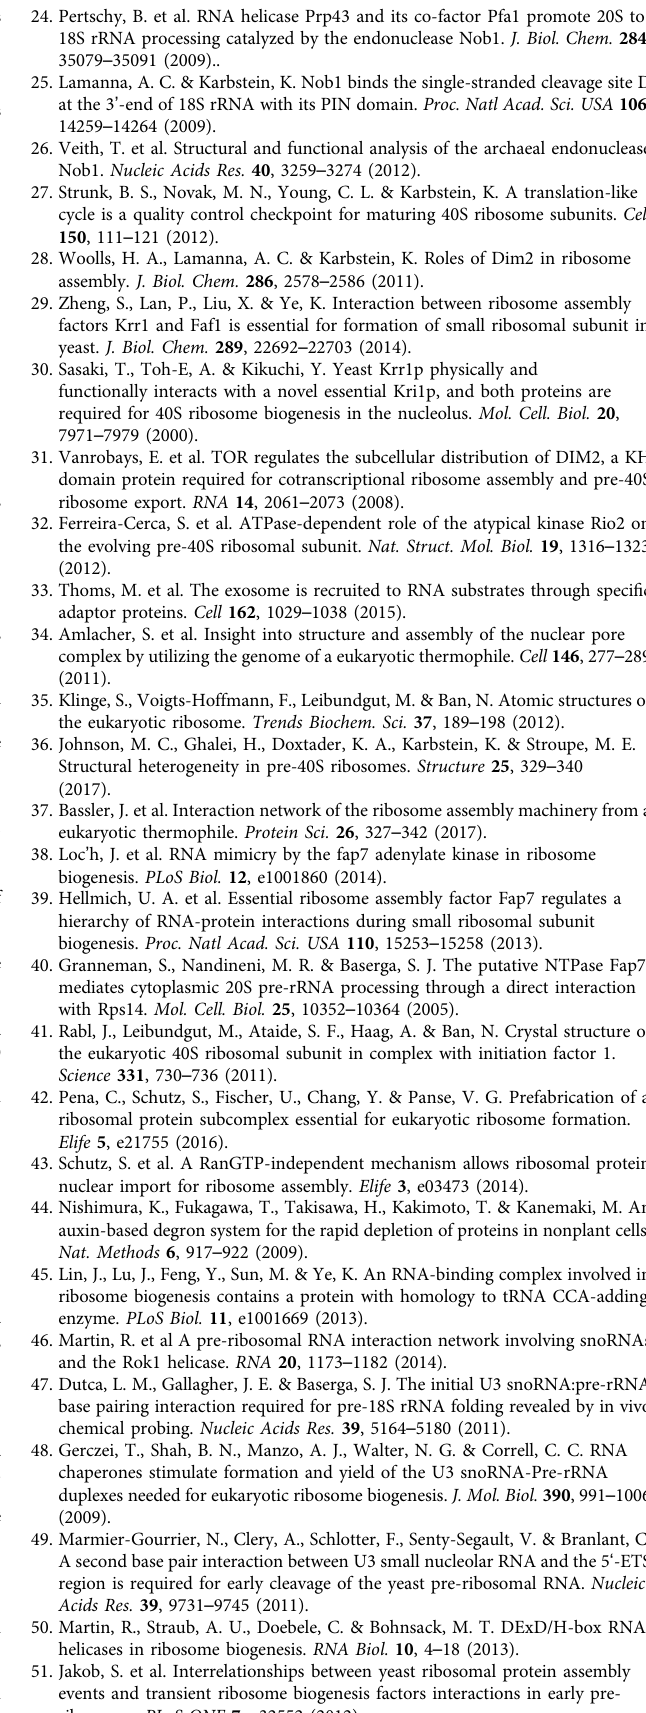
Figure preparation . All images displaying electron densities and molecular models were generated with UCSF Chimera 69 .